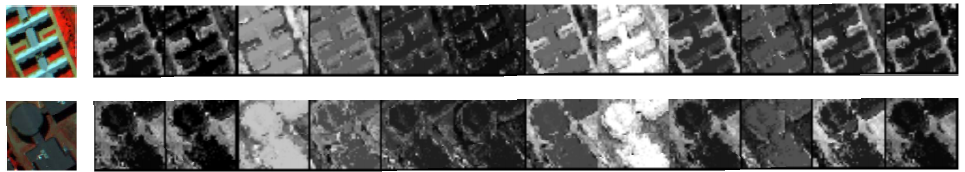
Figure 20. The heat maps of the generated involution kernels for metal sheet ( top ) and bitumen samples ( bottom ) from the UP